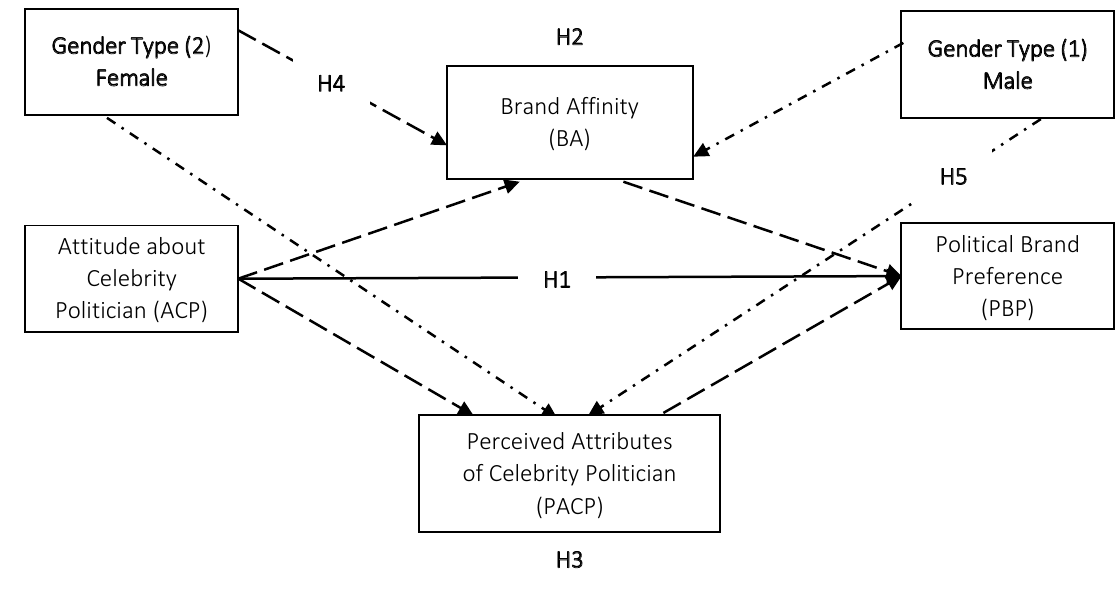
Figure 1. Research